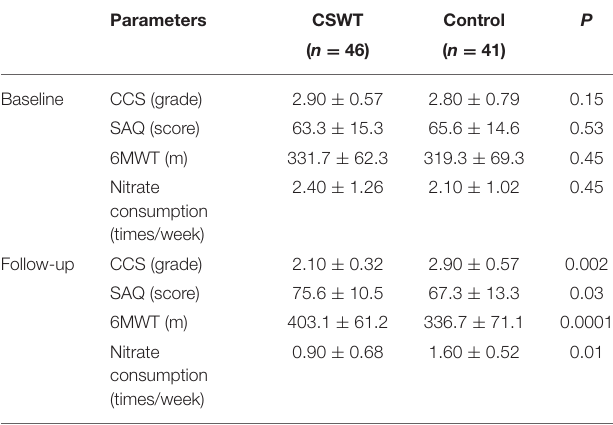
TABLE 1 | Characteristics of patients in two groups. CWST group